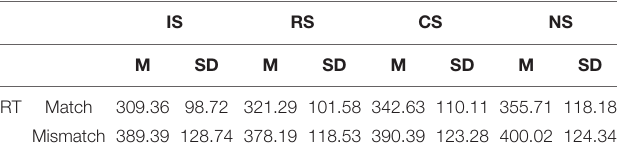
TABLE 1 | Mean reaction times for the variables of self and matching